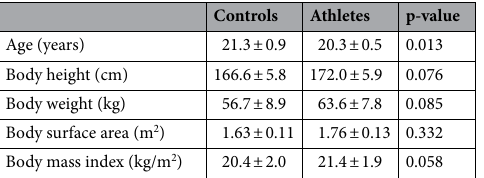
Table 1. Basic anthropometric characteristics of control and athlete subjects. Data are means ±